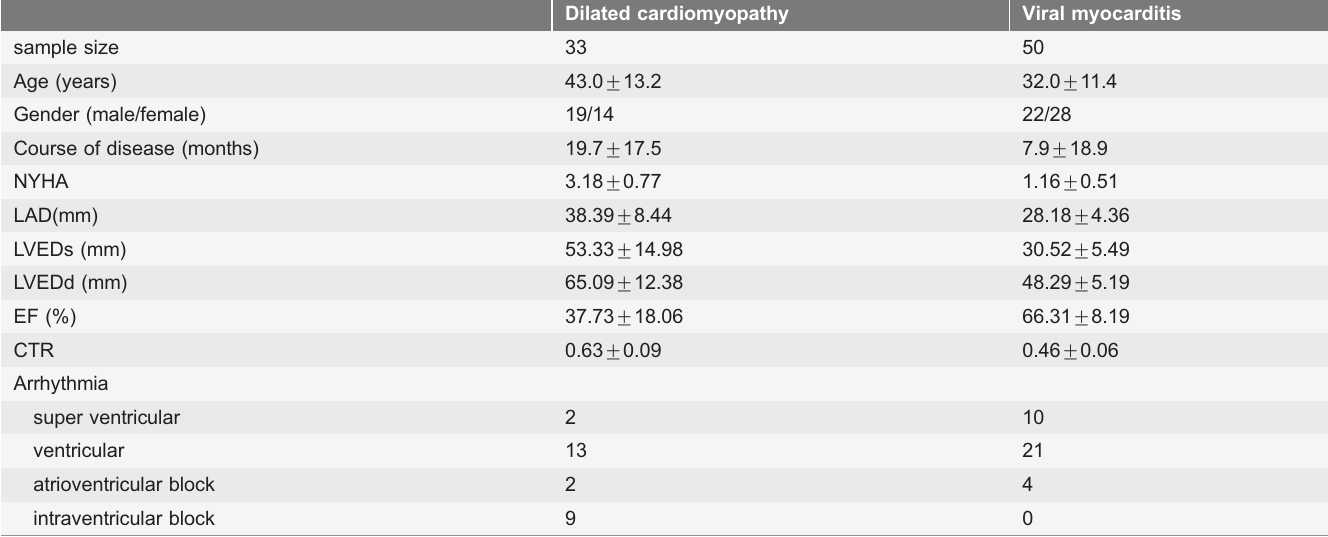
Table 1. The clinical data of including VMD patients (mean ¡